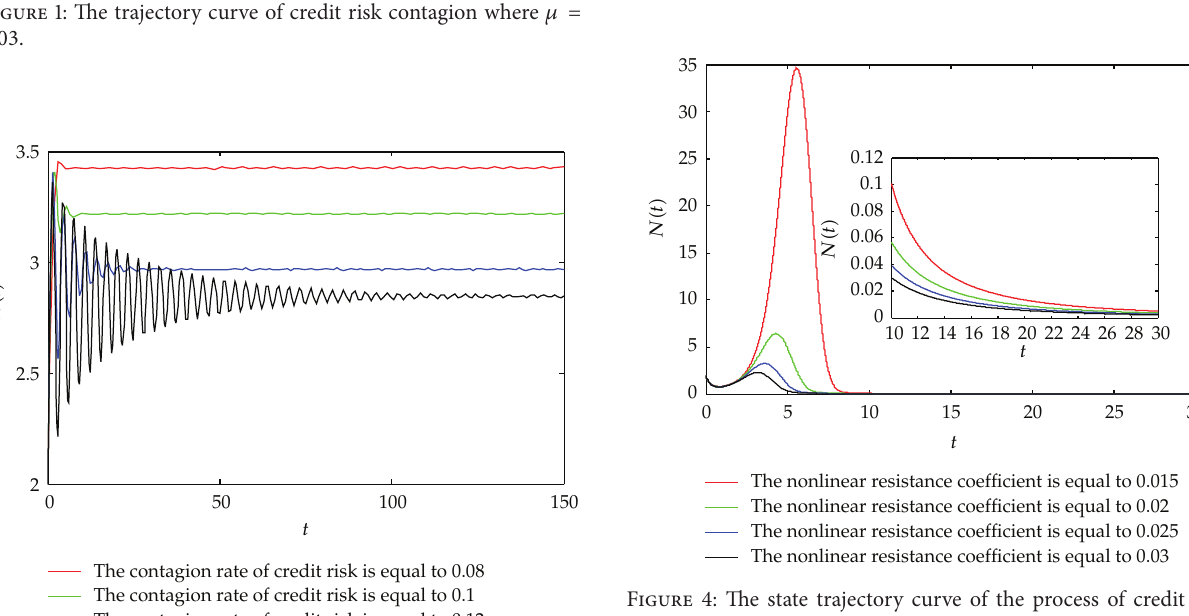
Figure 3: The phase diagram of the process of credit risk contagion where 𝜇 = 0.03 .